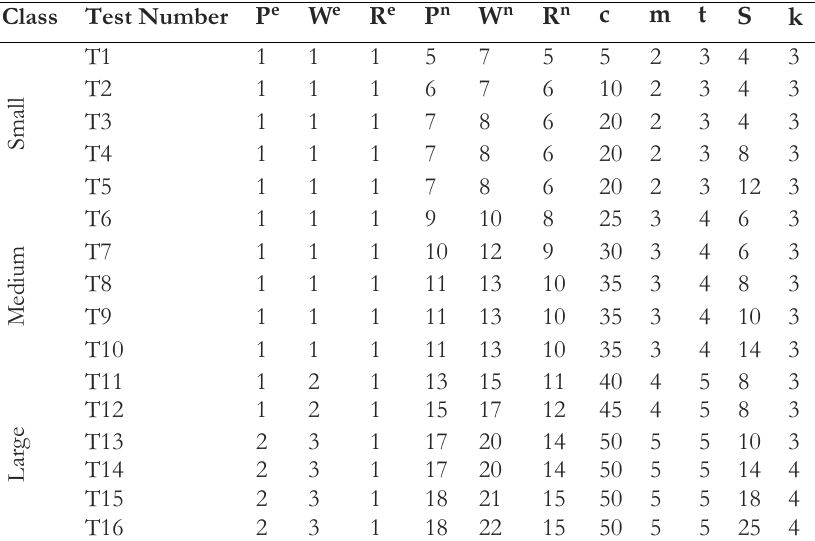
Table 10. Characteristics of test